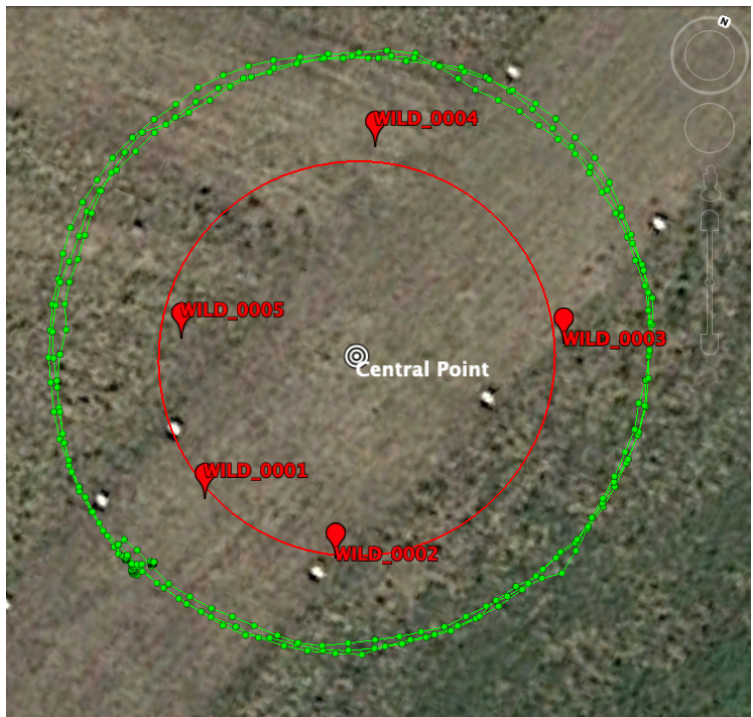
Figure 3. The smartphones followed various circle of a ca. 15-meter radius that contained the whole setup shown in Figure